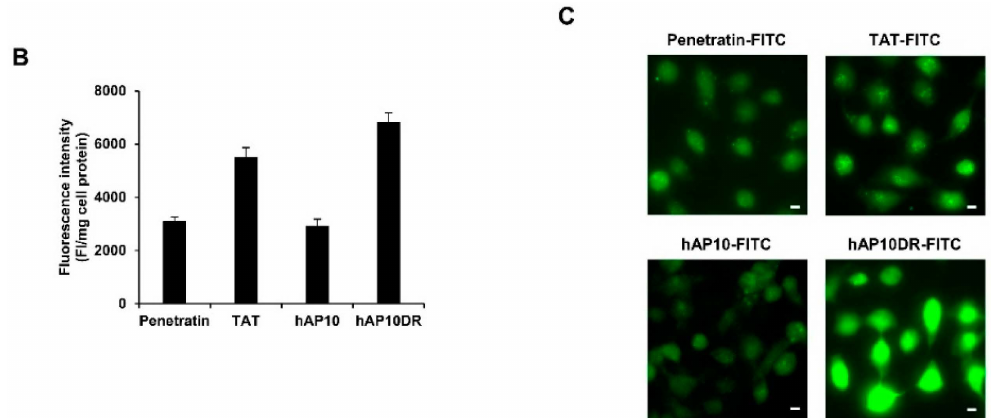
Figure 2. Cellular uptake of hAP10 and hAP10DR. ( A ) HUT78 cells were incubated with 5 µ M of FITC-labelled hAP10 and hAP10DR or penetratin and TAT as controls for 1 h in complete medium. Cells were then washed with PBS, incubated in trypsin-EDTA solution (0.01% trypsin) at 37 ◦ C for 10 min, resuspended in PBS and subjected to flow cytometry (right). Left: Bar diagram representing the uptake of the FITC-labelled peptides as mean cellular fluorescence from the flow cytometry analysis of live cells positive for FITC. Data are means ± s.e.m. ( n = 3). ( B ) Fluorescence quantification of FITC-labelled hAP10 and hAP10DR uptaken in human B lymphocytes. Cells were incubated with 5 µ M of FITC-labelled hAP10 and hAP10DR or penetratin and TAT as controls for 1 h in complete medium, washed with PBS and the fluorescence of the cell lysis measured as described in Material and Methods. Data are means ± s.e.m. ( n = 3). ( C ) (Bottom-right figure) Intracellular distribution of